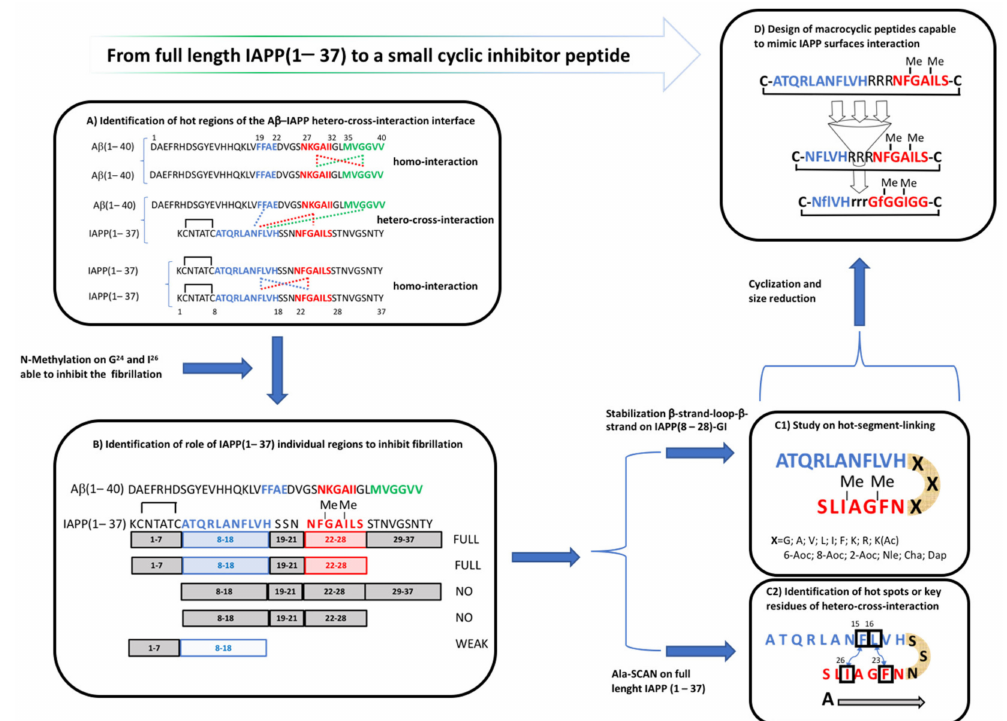
Figure 2. Kapurniotu’s hierarchical strategy applied on full length Islet Amyloid PolyPeptide (IAPP) (1–37) and short inhibitor fragment IAPP(8–28)-GI [149]: ( A ) Identification of hot regions of the A β -IAPP hetero-cross-interaction interface: summary of the determined cross- and self-interactions (solid arrows) between the hot regions (hot regions in blue, red, and green) of the A β -IAPP interaction interface [152]; ( B ) Role of IAPP individual regions: summary of the identified effects of the regions and shorter segments of IAPP-GI on A β 40 amyloid formation. Regions in blue and red, or in light blue indicate regions or segments able to assemble both with A β 40 and IAPP. Sequences in black indicate regions or segments that had no effect on the assembling processes [153]; ( C1 ) Study on hot-segment-linking on IAPP(8–28)-GI [154]; ( C2 ) Identification of hot spots or key residues of its hetero-cross-interaction and self-interactions between IAPP and A β [155]; ( D ) Design of macrocyclic peptides capable to mimic IAPP surfaces interaction